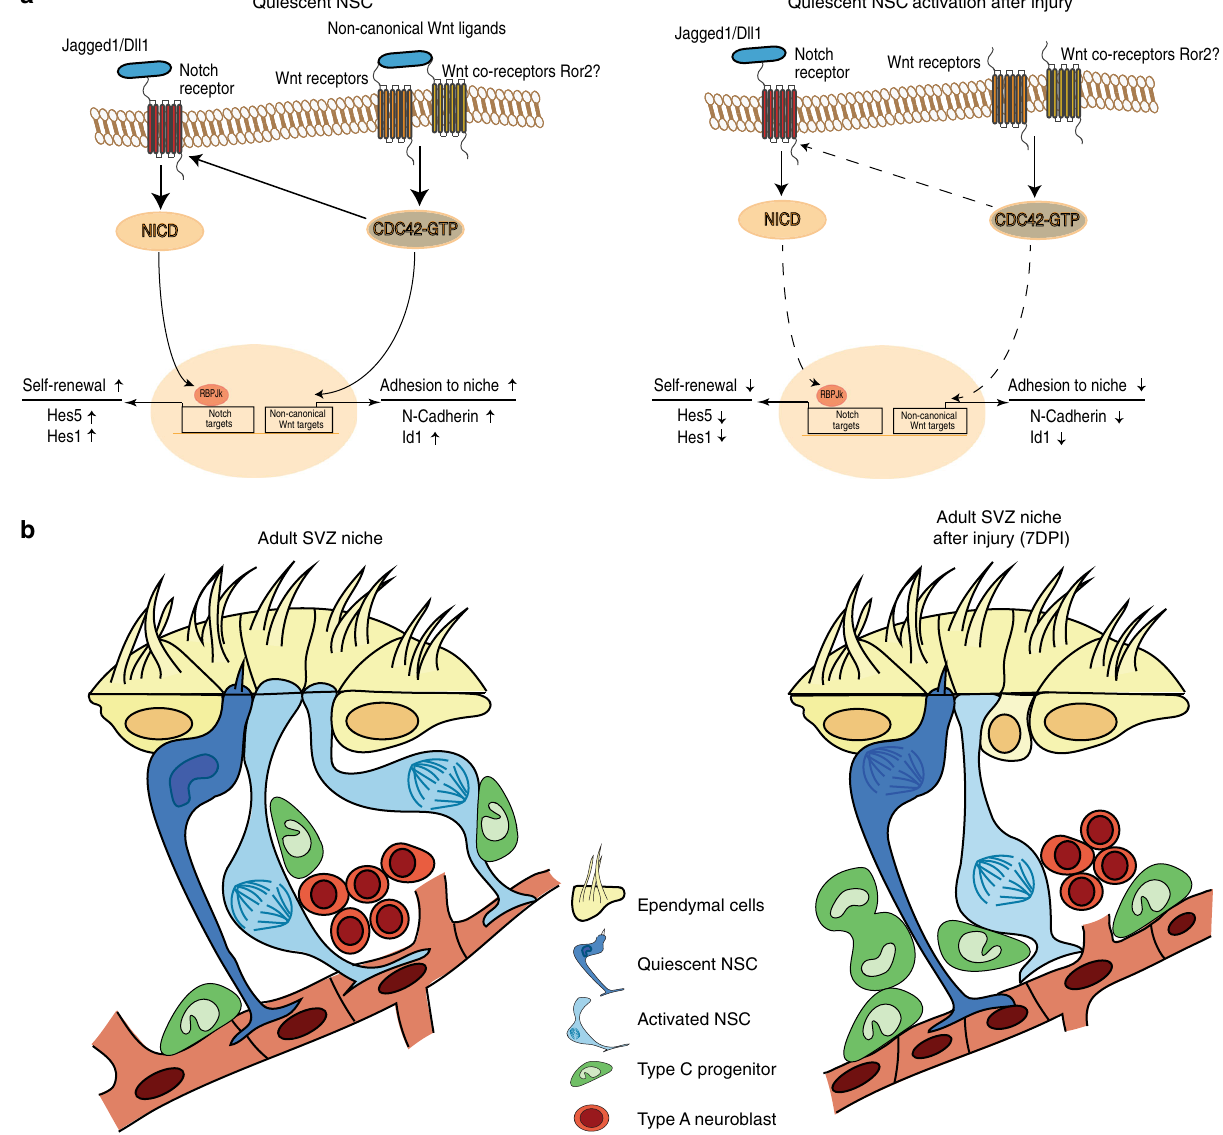
Fig. 8 Proposed mechanism for maintenance of NSC quiescence in the SVZ during homeostasis and activation after injury. a Model of quiescent NSC maintenance under homeostatic conditions and after a demyelination injury. The quiescent state is maintained by non-canonical Wnt signaling-induced Cdc42 activity and its downstream targets Notch1, Id1, and N-Cadherin, thereby maintaining NSC self-renewal and anchorage to the SVZ niche. During a demyelination injury, a decrease in non-canonical Wnt ligand expression leads to a decrease in Cdc42 activity which disrupts Notch signaling and adhesion of qNSCs to the SVZ niche, which then undergo increased activation and lineage progression to generate progenitors. b Cytoarchitecture of the SVZ in normal physiology and after a demyelination injury (7DPI). During a demyelination injury, quiescent NSCs enter the cell cycle to undergo increased lineage progression and generate higher numbers of transit-amplifying progenitors that initiate the process of tissue